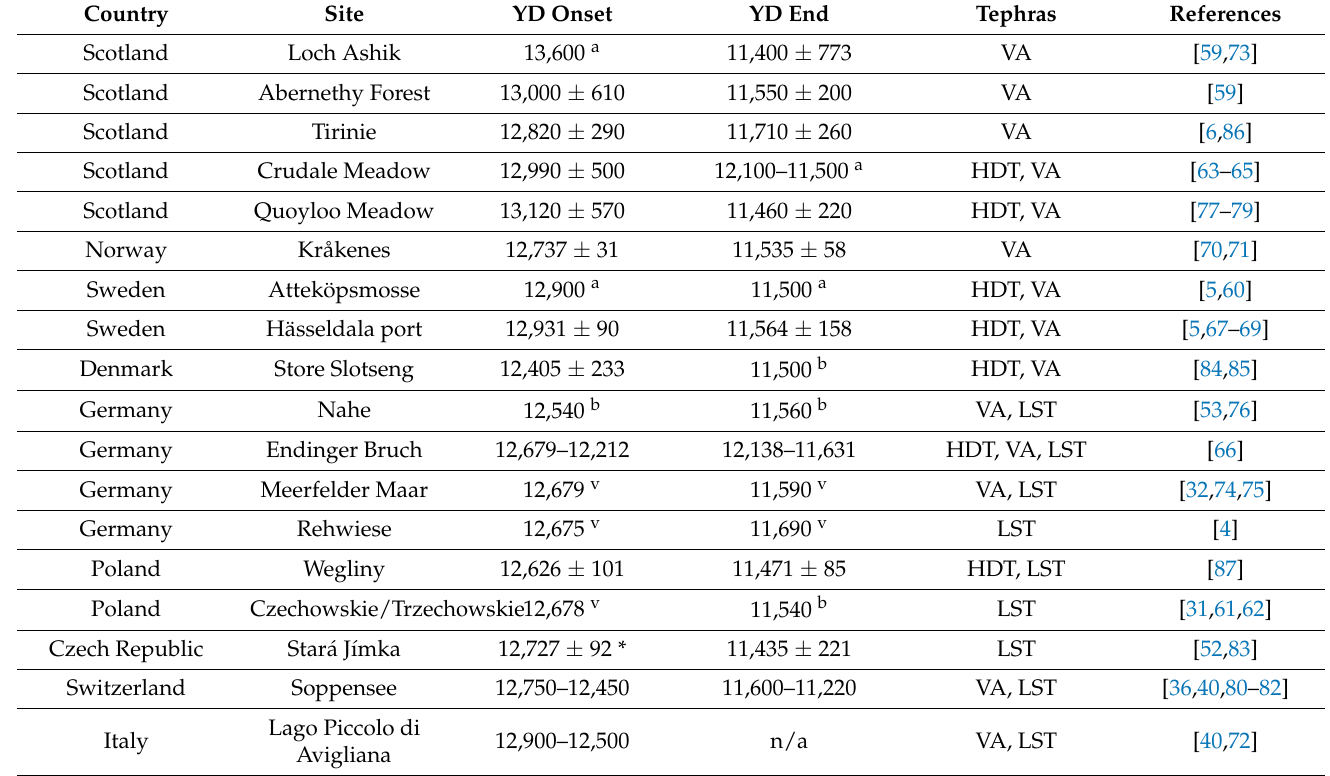
Table 1. Best available age estimates of the Younger Dryas (YD) onset and end at the comparison sites, presented as expressed in the source and as cal. a BP unless otherwise noted. Tephras identified at each site are indicated by their abbreviations: the Hässeldalen Tephra (HDT); the Vedde Ash (VA); and the Laacher See Tephra